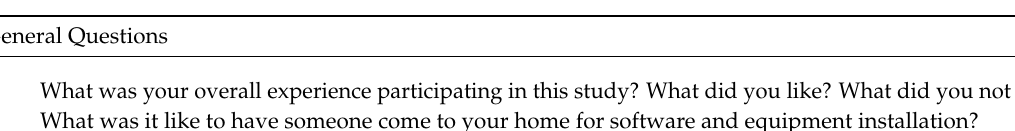
Table 2. Focus group